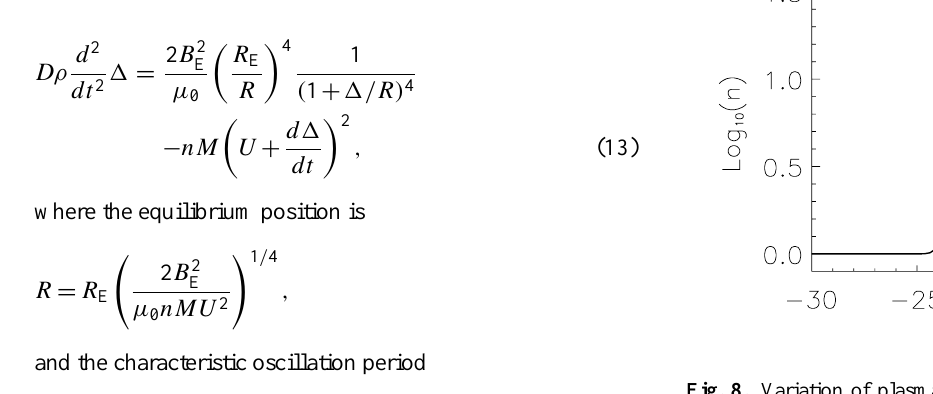
Fig. 6. The magnetic field intensity, here represented by ln ( | B |+ 1 ) , is shown in color coding with selected magnetic field lines superim- posed. Distances are normalized with the Earth radius R E . See cor- responding Fig. 7 for the plasma density. The Sun is in the negative x-direction.